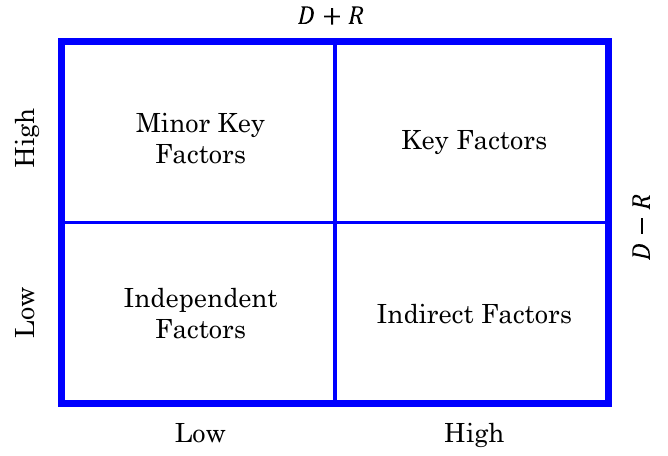
Figure 1. The prominence-relation map.